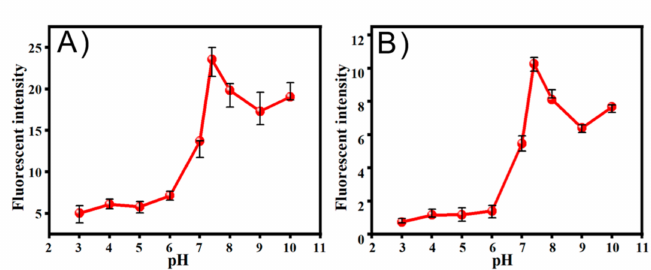
Figure 7. The effects of pH values on the fluorescence intensity of ( A ) TCF-ether and ( B ) DCI-ether.